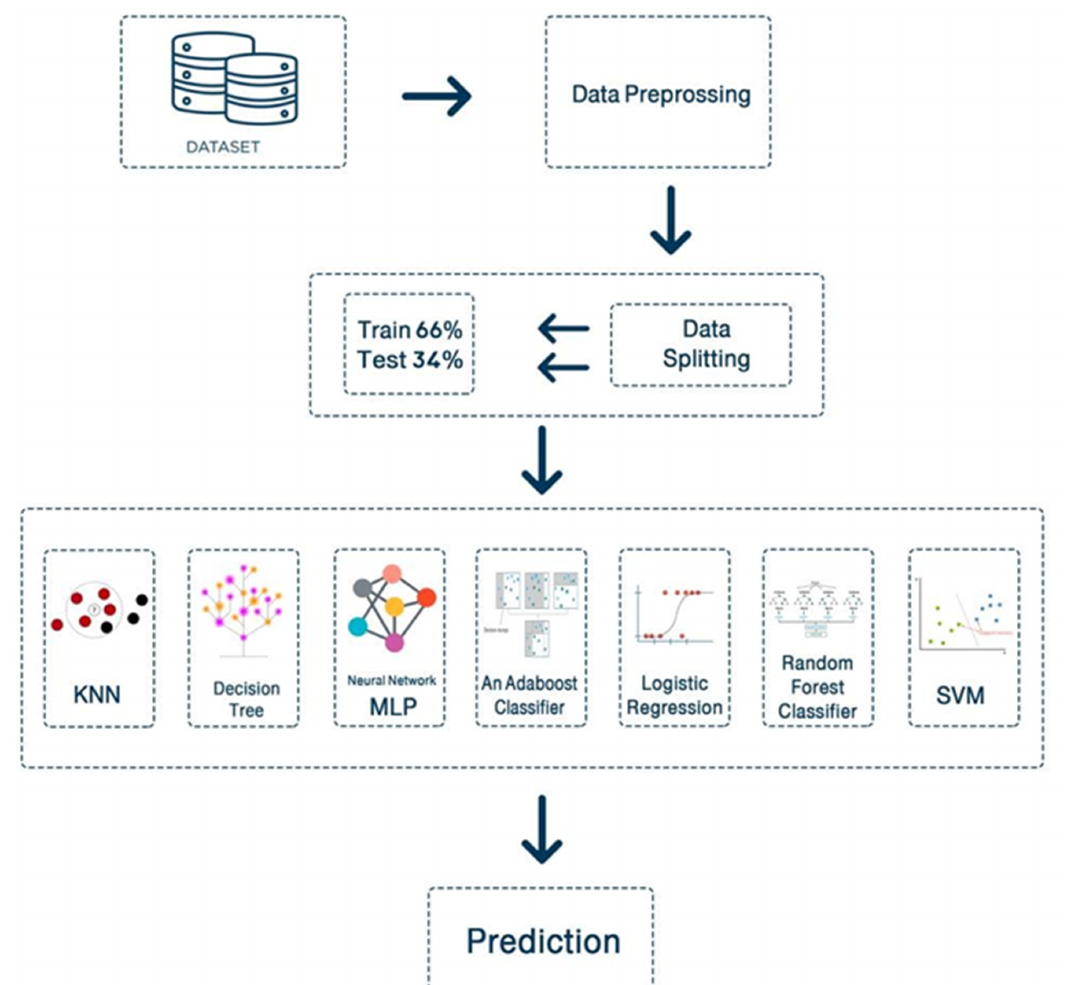
Figure 4. The proposed diabetes prediction/monitoring system in intelligent health